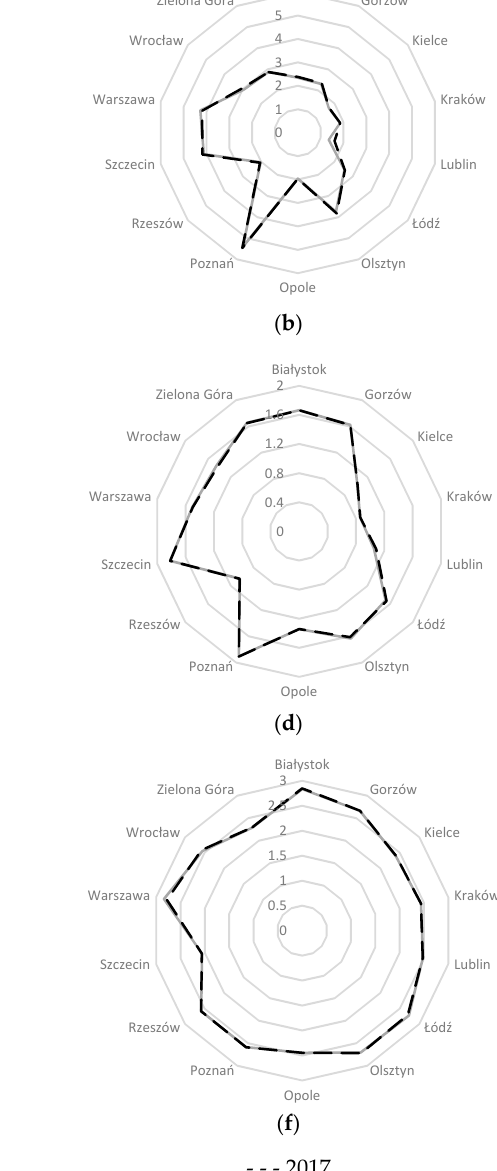
→ iu ; ( b ) Urbanization pressure—UP(j